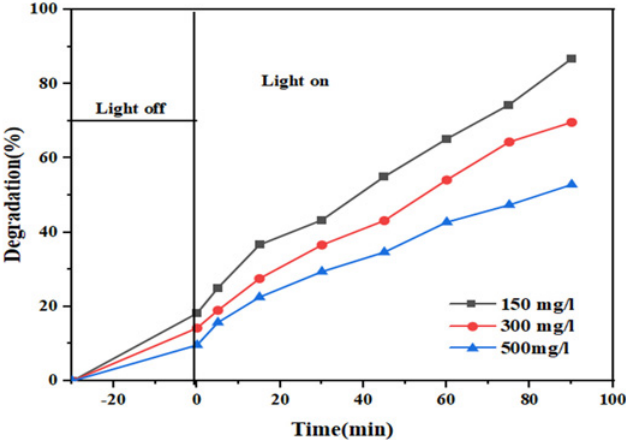
Fig. 6. Effect of initial concentration of albumin on photocatalytic